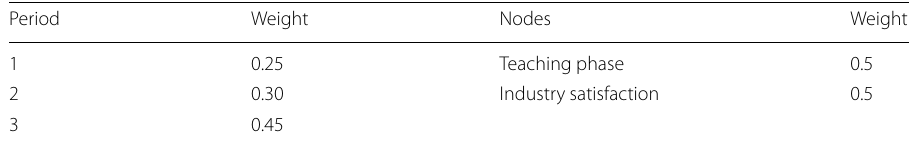
Table 4 Weights for periods and nodes Period